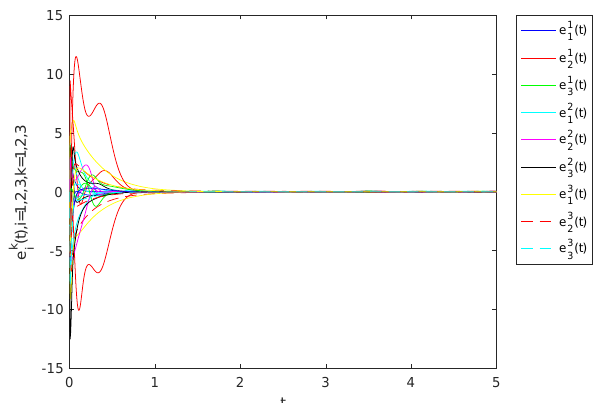
Figure 12. Synchronization error without inter-layer couplings under Controller (4).